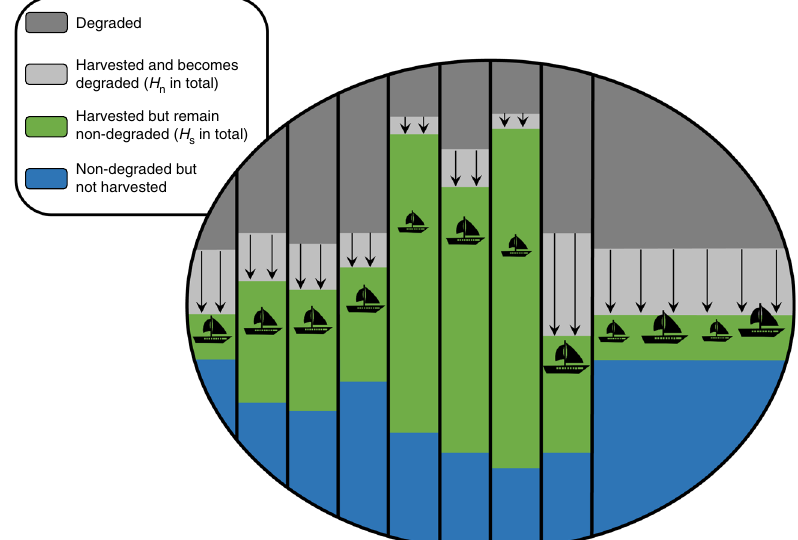
Fig. 1 Schematic illustration of the model. Demonstrated is the state of the system at the global scale (e.g., the entire planet ’ s marine area, forest area, or agricultural area) in a given year. The dark-gray area characterizes the part of the system that is degraded due to former non-sustainable harvesting. The light gray area with the arrows characterizes the part of the system that is being harvested non-sustainably and will be degraded starting next year (total dark-gray area is given by H n ). The green area with the fi shing vessels characterizes the part of the system that is being harvested sustainably and will remain non-degraded next year (total green area is given by H s ). (Note that the total area under harvest, H , is given by the green and the light gray areas combined, H = H n + H s ). The blue area characterizes the part of the system that is not degraded but is still not being harvested. We assume that the spatial scale of the system is very large, and therefore, the recovery of the degraded areas due to migrating biota from other regions is negligible and the total degraded area increases over time. Each year, H n and H s are determined by the aggregate management by all the managers. We assume that managers may be subject to different externalities in distinct regions, e.g., some regions are managed by a single manager that dictates the harvest method, while some regions are shared (open-access), and all managers are free to harvest in them (rightmost region). The variables x 1 and x 2 (Eqs. 7 and 8) characterize the total non-degraded areas (blue, green, and light gray) in the managed and in the shared regions,